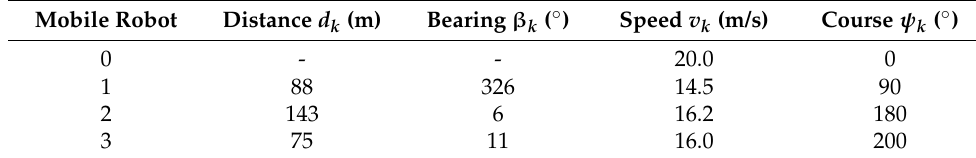
Table 1. Data of mobile robot 0 and encountered (K = 3) mobile robots.